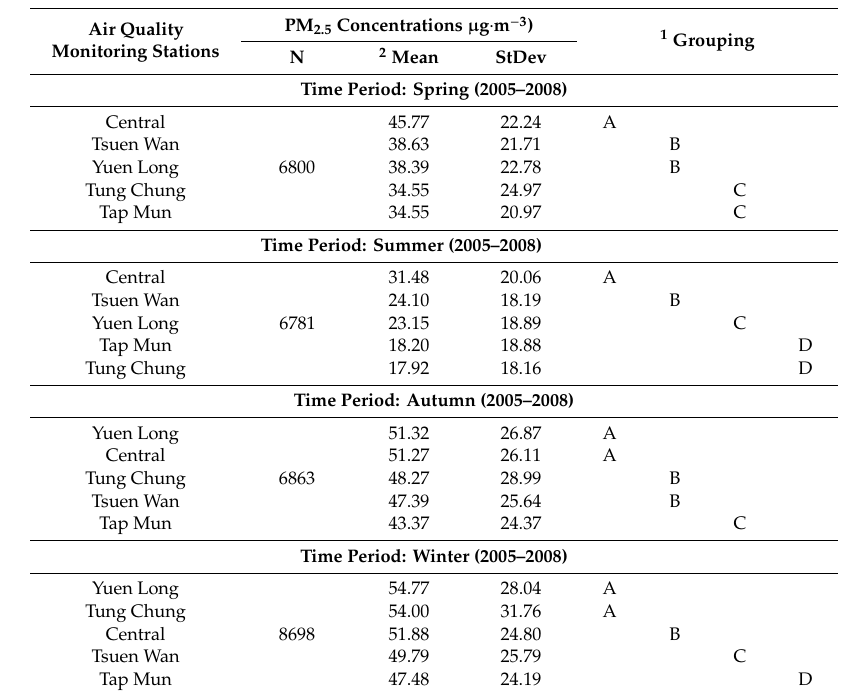
Table 3. Seasonal statistics of PM 2.5 mass concentrations observed at the air quality monitoring stations in Hong Kong from 2005 to 2008 using the one-way ANOVA test. N corresponds to the number of hourly observations in a season.